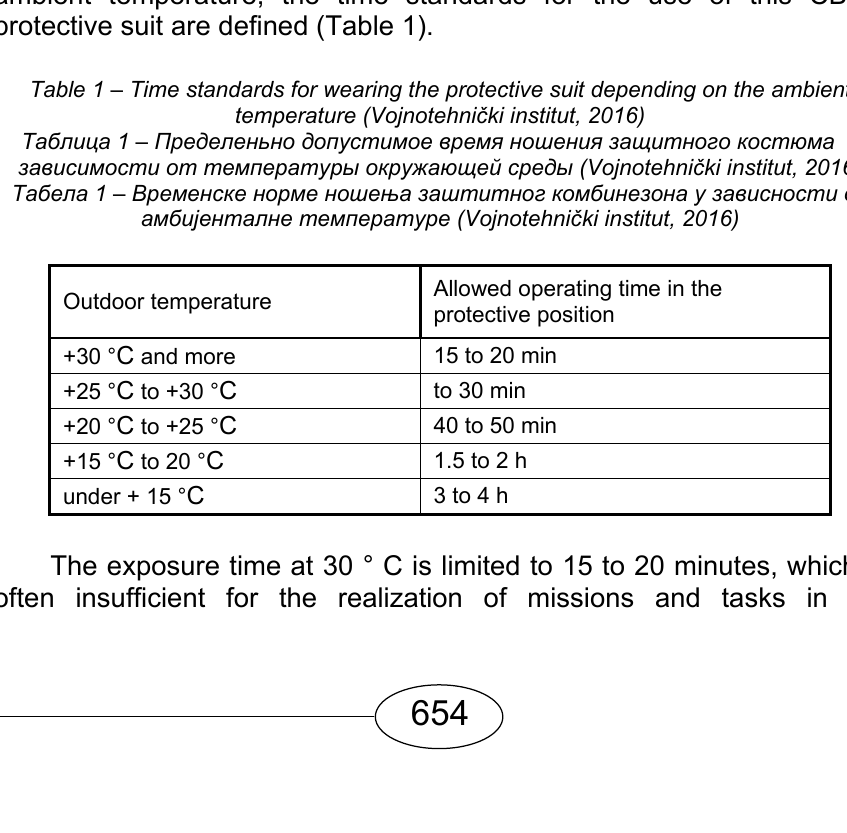
Table 1 – Time standards for wearing the protective suit depending on the